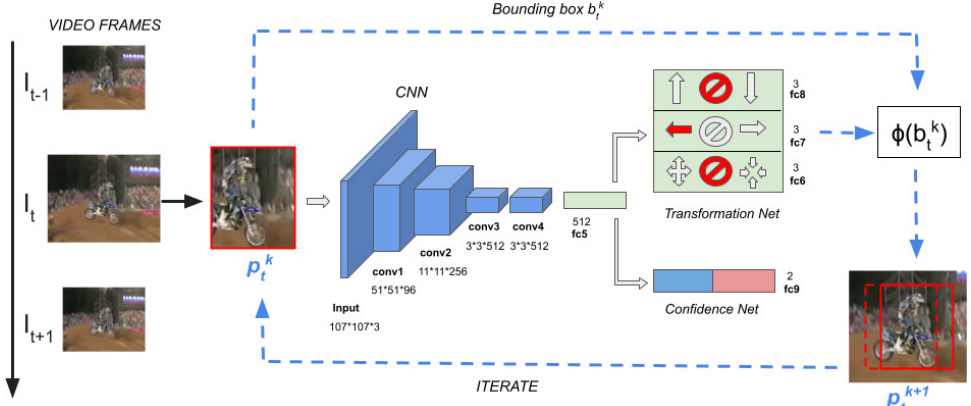
Figure 4. Architecture of our model. On the left, the arrow indicates the flow of frames. At time t , starting from the bounding box estimated at time t − 1, the method iterates a sequence of multiple transformations highlighted in red on the right side. The transformations are applied to the bounding box, which is used to get a new image patch to feed the